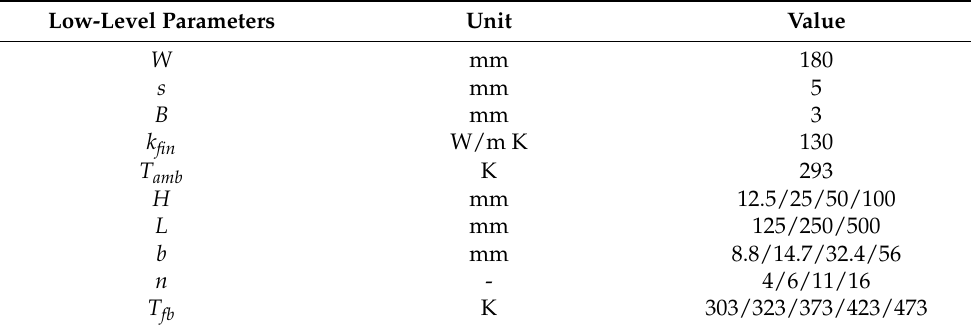
Table 3. Low-level parameters for calculation path